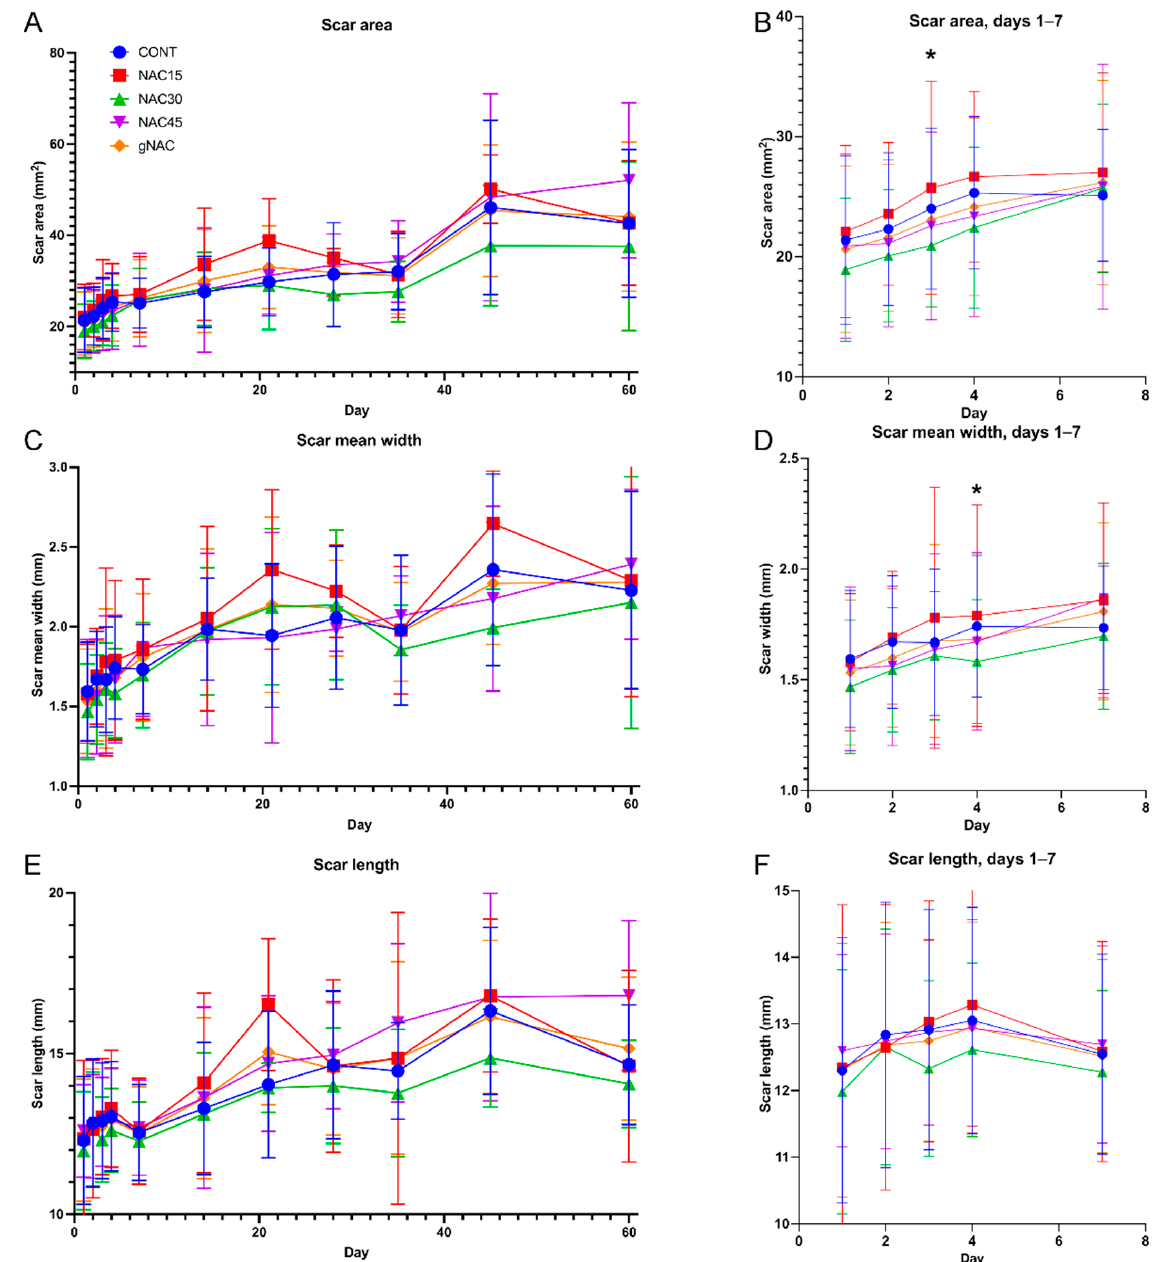
Figure 2. Graph represents results of planimetric measurements of photographed scars. ( A ) scar areas at days 1–60, ( B ) scar lengths at days 1–7, ( C ) scar mean width at days 1–60, ( D ) scar mean width at days 1–7, ( E ) scar lengths at day 1–60, ( F ) scar lengths at day 1–7. Mean results ± SD. * p < 0.05 (NAC30 vs. CONT).